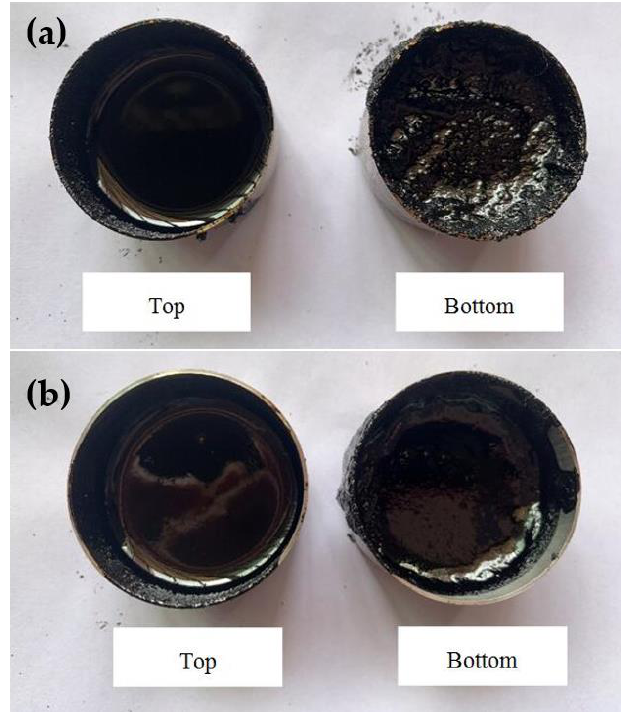
Figure 13. A–G–R and CRMA stored 72 h at 163 °C. ( a ) The image of CRMA; ( b ) the image of